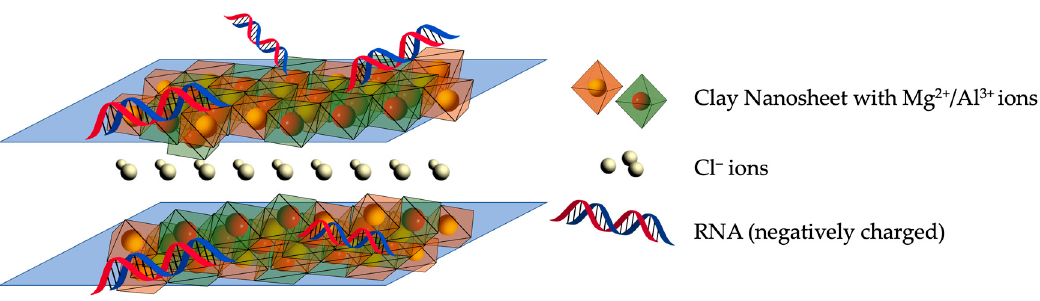
Figure 2. Intercalating LDH nanosheets (magnesium/aluminum ions clay) and chloride ions form a strong layered structure. The metal cations capture dsRNA (R-PO 42 − ) via strong ionic interactions. Color image available online.